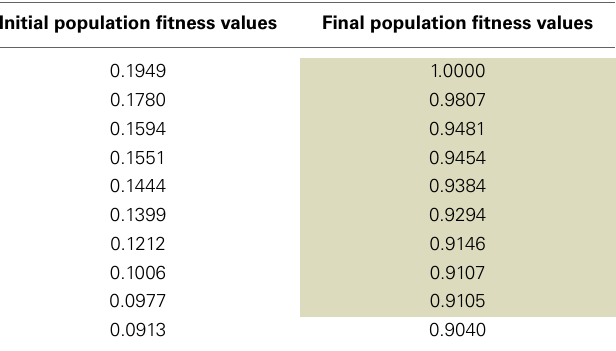
table entries denote SNNs that produced SORFs and V1 sim- ple cell-like tuning curves for all four Exc group neurons while unshaded table entries indicate SNNs that failed to produce these neural phenomena. All SNNs from the initial population had very low fitness, produced no orientation selectivity, and had no SORF formation. All SNNs from the final population except for the last individual (fitness = 0.9040) had high fitness values, produced V1 simple cell-like tuning curve responses, and produced SORFs. The last individual in Table 2 , had a high fitness, but only pro- duced V1 simple-cell like tuning curve responses and SORFs in three of the four Exc group